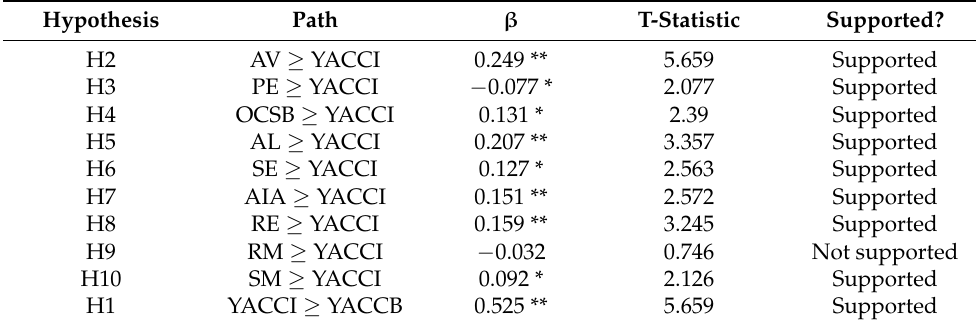
Table 5. Main effect test results.